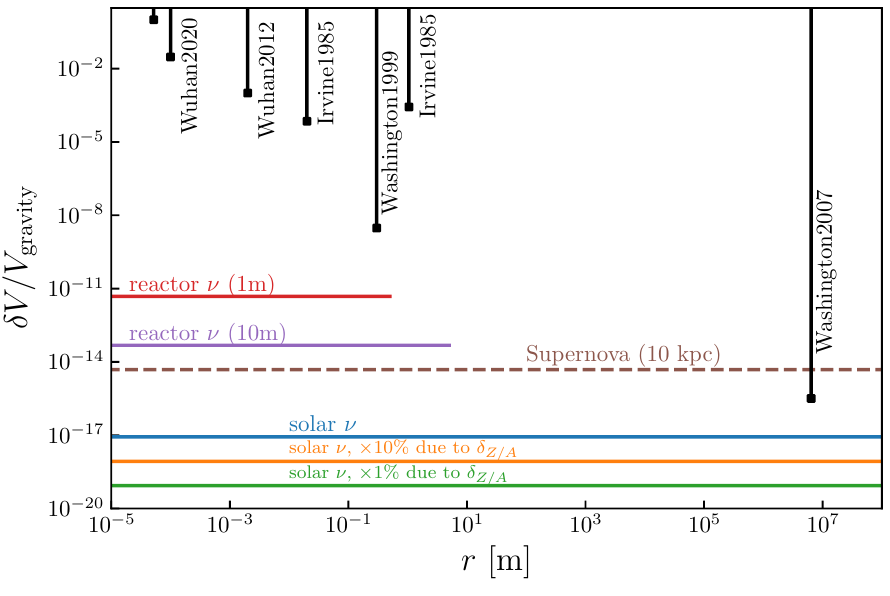
Figure 5 . Neutrino forces in comparison with experimental sensitivities. Here all neutrino sources are assumed to be ideally point-like and the angular spread is assumed to be sufficiently small to meet eq. (4.14). In reality, a sizable angular spread needs to be taken into account thus the above should be considered as an upper bound of the